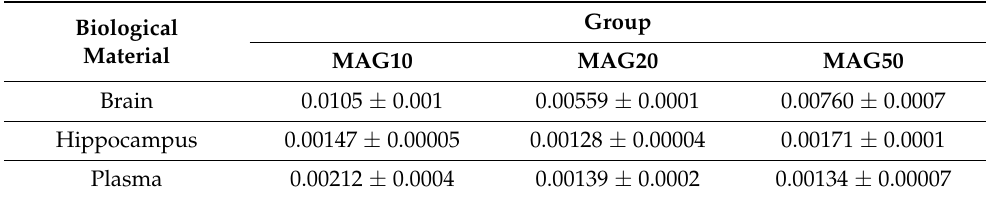
Table 3. The content of MAG in the tested biological material: hippocampus, brain and plasma